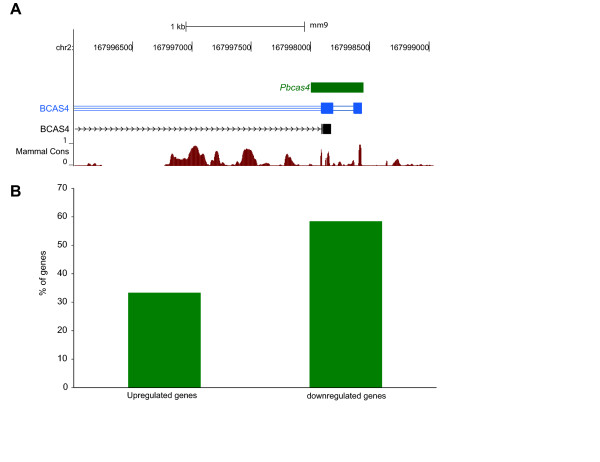
The conserved function of Pbcas4 as a competitive endogenous RNA. (a) Genome browser view of the transmap annotation (blue track) for the human breast carcinoma amplified sequence 4 (BCAS4) unitary pseudogene in mouse, pbcas4. The tBLASTn alignment available from UCSC between the BCAS4 peptide and the mouse genome is in grey. The full length transcript in N2A (green) is transcribed from chr2:167,998,005-167,998,447 (mm9) and aligns to the 3' UTR region of the human BCAS4 gene The mammalian conservation track on the bottom (UCSC genome browser) shows the degree of placental mammal base pair conservation (20 species). (b) Knock-down of Pbcas4 expression leads to down-regulation of protein-coding genes that have conserved human and mouse MREs for miR-185/882 and miR-665 families. The percentage of genes that have a conserved (mouse and human) MRE for either miR-185/882 or miR-665 (Y-axis) is 33% and 58% for genes up- and down-regulated, respectively, upon Pbcas4 knockdown.